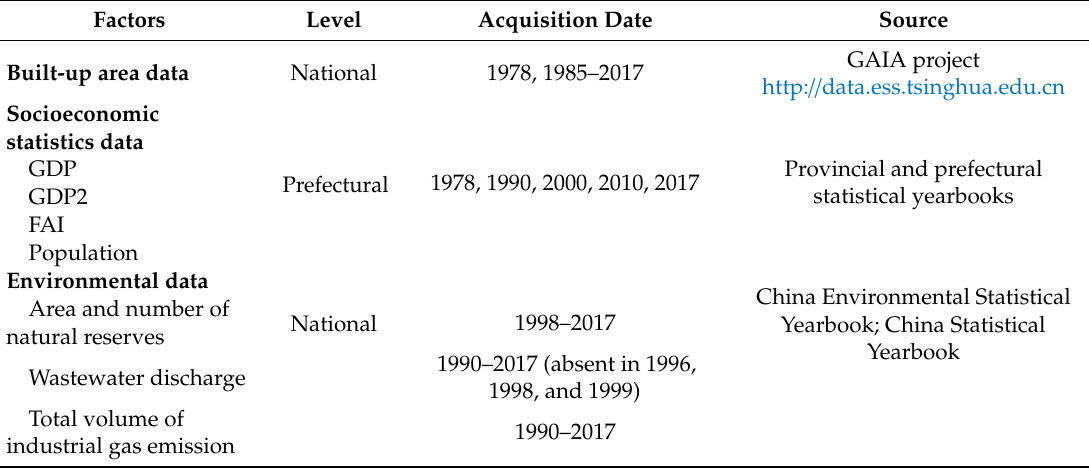
Table 1. Data in this